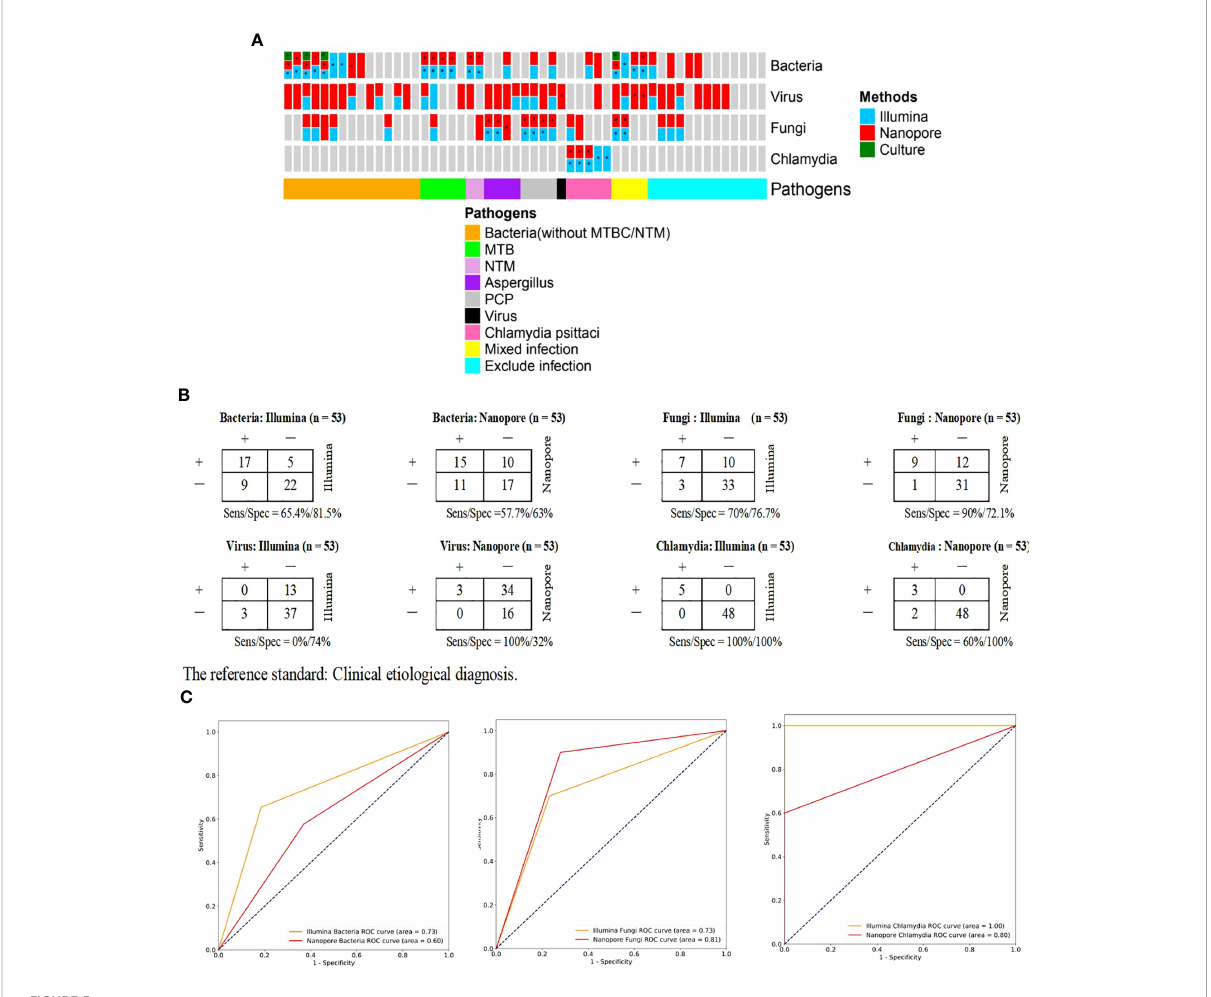
FIGURE 5 Comparison of diagnostic performance of Illumina and Nanopore for the main pathogens in BALF of patients with suspected CAP. (A) , Con fi rmation/exclusion of pathogenic infection in 53 patients using Illumina, Nanopore and culture. *: The results were consistent with the clinical etiological diagnosis. (B) , Contingency tables for the Illumina and Nanopore in detecting different classes of pathogenic microorganisms. Clinical etiological diagnosis was used as a reference method. (C) . ROC curves strati fi ed by classes of